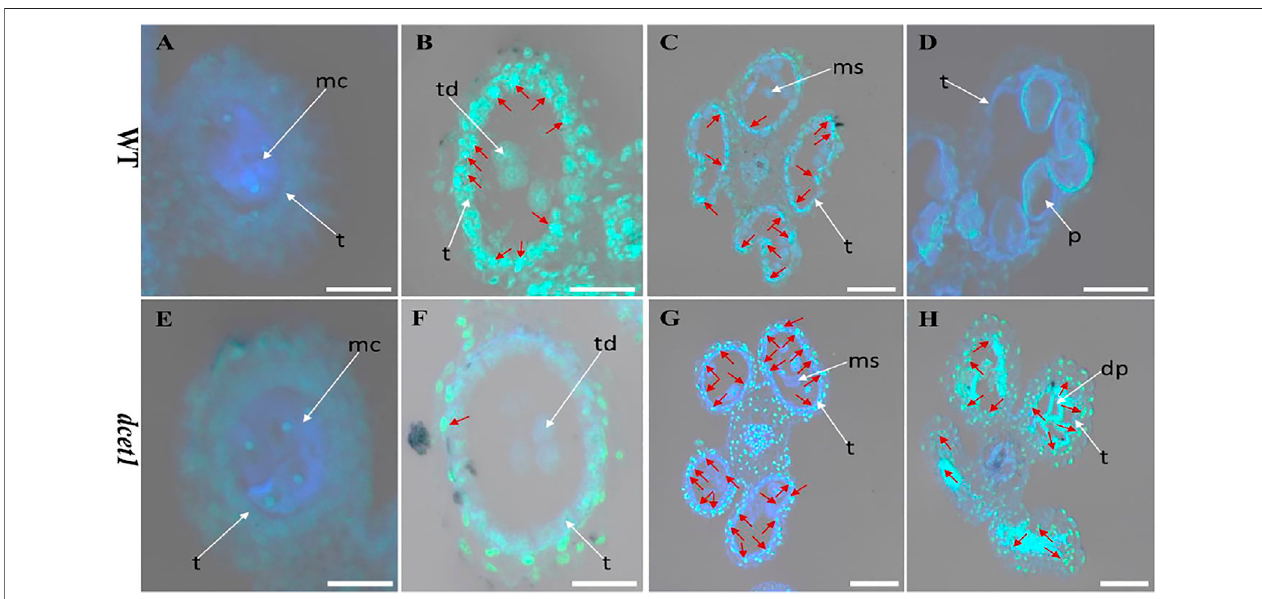
FIGURE 7 | TUNEL analysis of wild-type (WT) and mutant ( dcet1 ). Anthers of WT (A – D) , and dcet1 (E – H) , for pre-meiosis, meiosis, post-meiosis, and mature pollen stages of anther development, respectively. Red arrow highlights the strength of TUNEL signals. t, tapetum; mc, meiocyte; td, tetrad; ms, microspore; p, pollen; dp, defective pollen. Scale bars (cid:1) 20